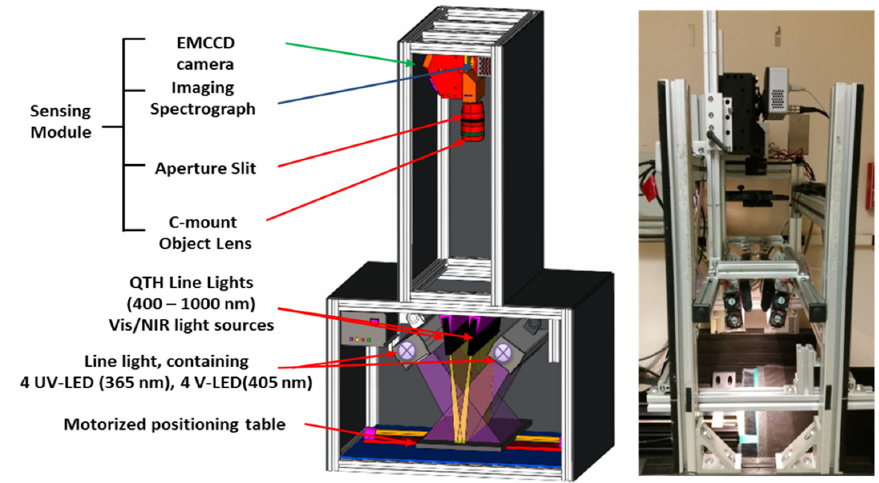
Figure 1. Schematic illustration and color photo of hyperspectral imaging (HSI) system. Only the violet (405 nm) LEDs were used as excitation source for fluorescence imaging application in the current